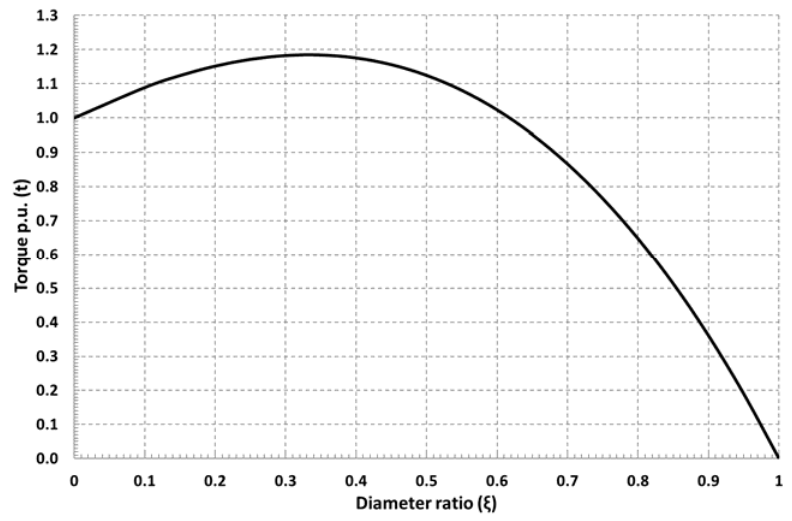
Figure 4. Torque p.u., t, versus diameter ratio ξ .